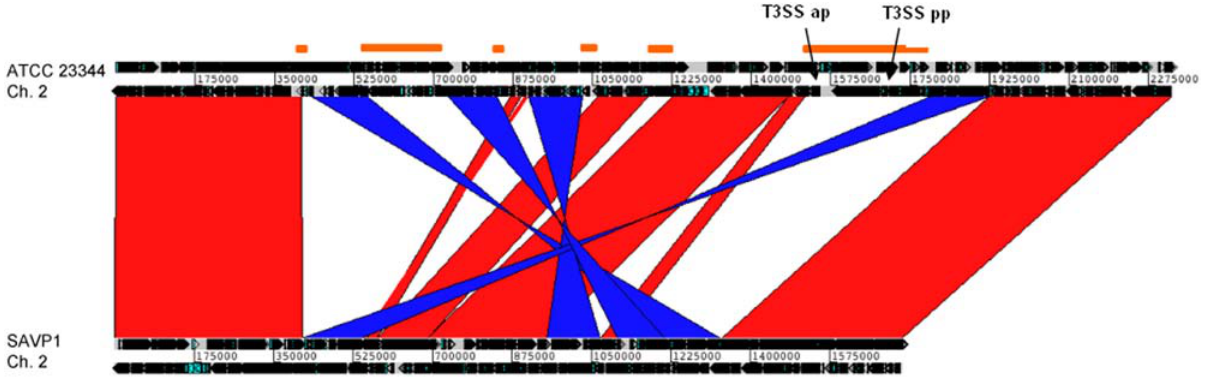
Figure 1. Comparison of the small chromosomes of B.mallei ATCC 23344 (top) and B.mallei SAVP1 (bottom) using ACT and the whole genome alignment MUMmer. Regions of similarity, rearrangements, and deletions are readily apparent between these two strains. The red and blue bands represent the forward and reverse matches, respectively. The orange horizontal bars represent the regions of ATCC 23344 that are missing in SAVP1. The locations of the animal pathogen-like T3SS (T3SS ap) and the plant pathogen-like (T3SS pp) gene clusters that are present in ATCC 23344, but absent in SAVP1, are indicated by arrows. The ATCC 23344 small chromosome (CP000011) is 2.32 Mb and the SAVP1 small chromosome (CP000525) is 1.73 Mb.